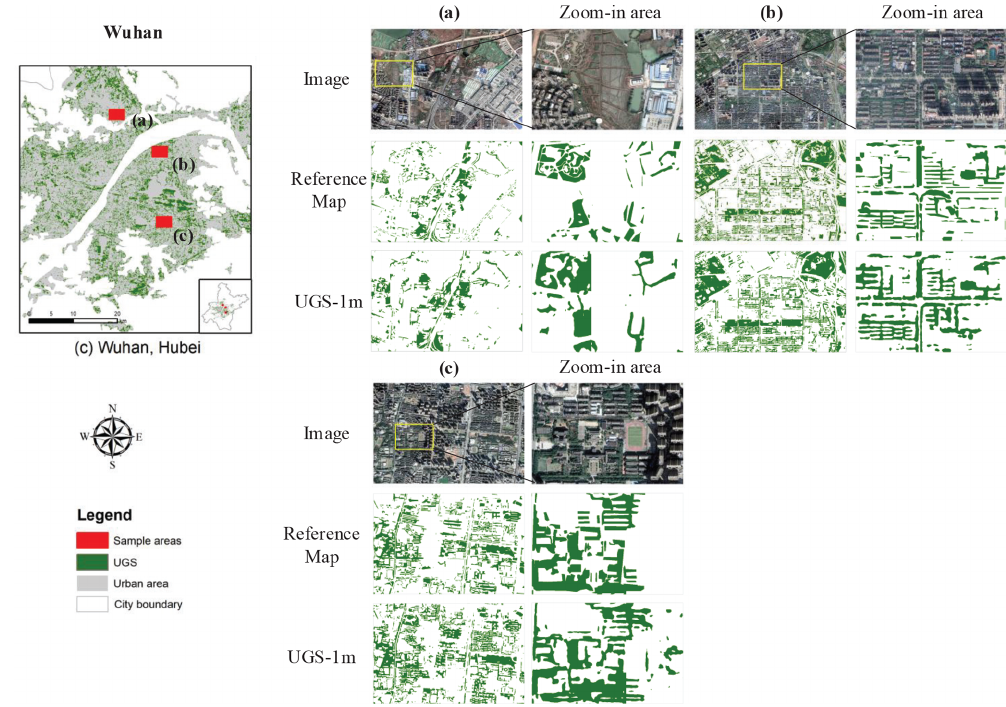
Figure 15. Qualitative analysis in UGS-1m, with a case study in Wuhan city. Panels (a) – (c) are three example areas collected from Wuhan. Images are from © Google Earth